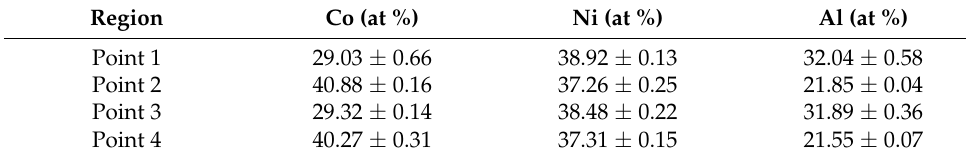
Table 1. The EDS results of the as-cast Co 39.8 Ni 39.8 Al 21.6